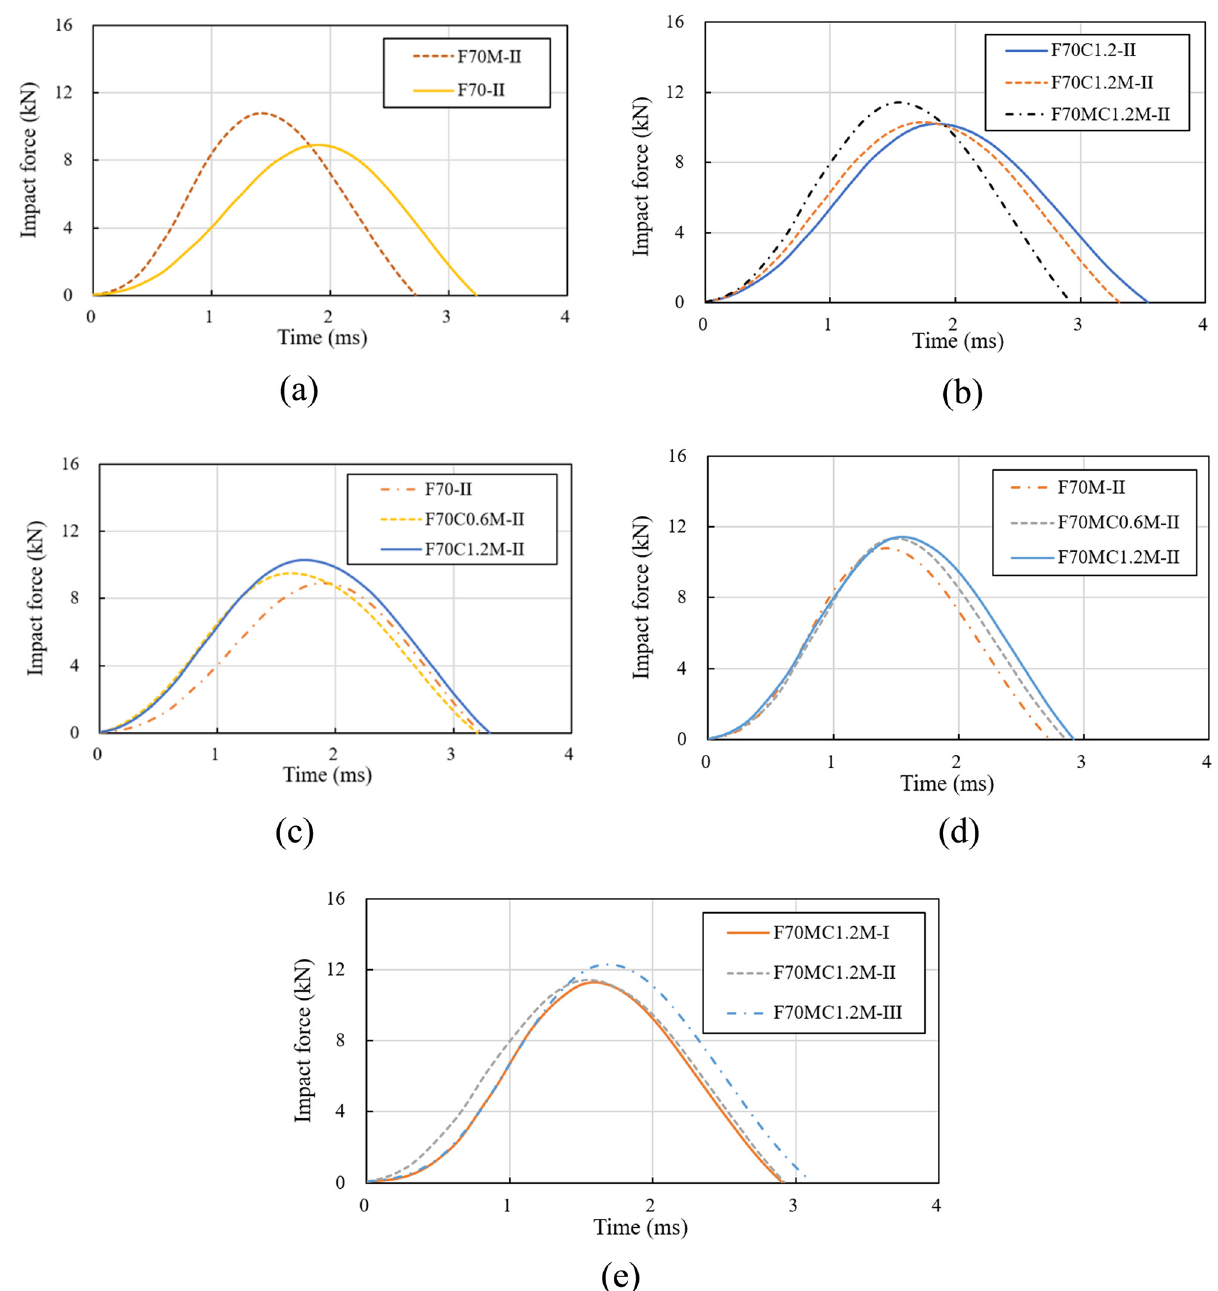
Figure 7: Impact force histories: ( a ) in fl uence of the modi fi ed HGMs, ( b ) in fl uence of the modi fi ed HGMs and MWCNTs, ( c ) in fl uence of the contents of modi fi ed MWCNTs on specimens with unmodi fi ed HGMs, ( d ) in fl uence of the contents of modi fi ed MWCNTs on specimens with modi fi ed HGMs, and ( e ) in fl uence of the applied impact